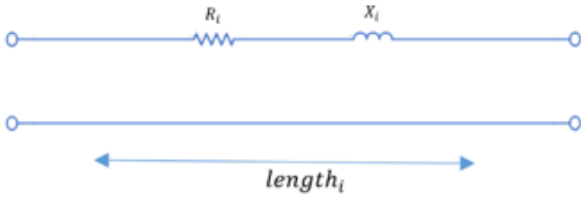
Figure 1. Series model of a healthy line [14].